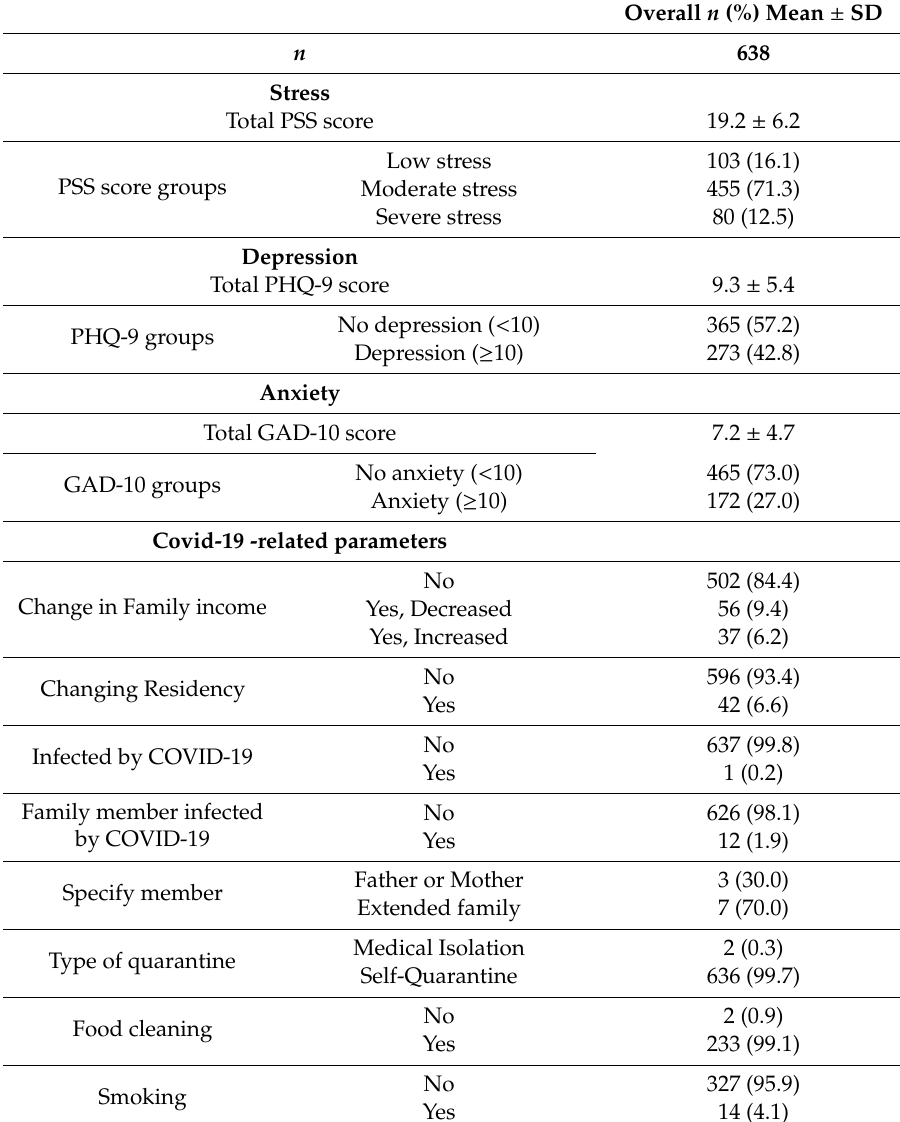
Table 2. Mental status and parameters related to